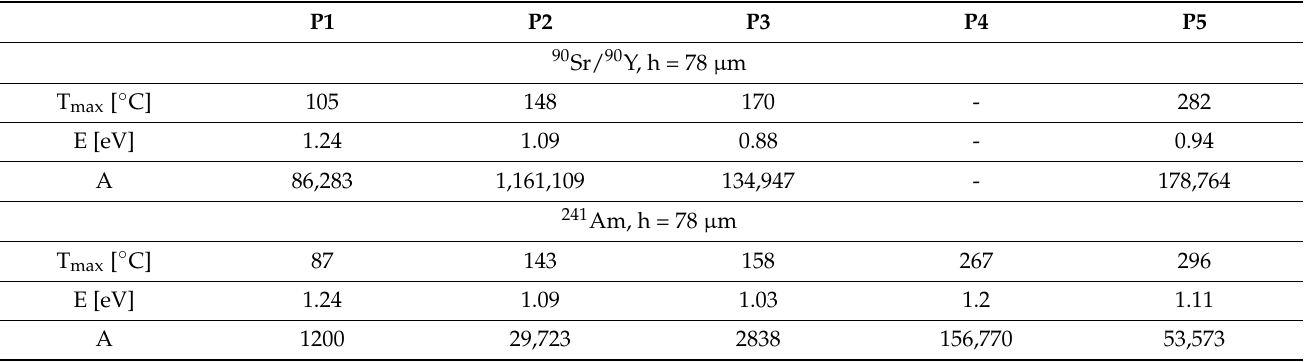
Figure 10. Analysis of TL glow-curve shapes of the investigated SCF samples after irradiation with X-rays ( Panel A ). Panel B —The relationship between the ratio of TL peak 1 to TL peak 2 and the